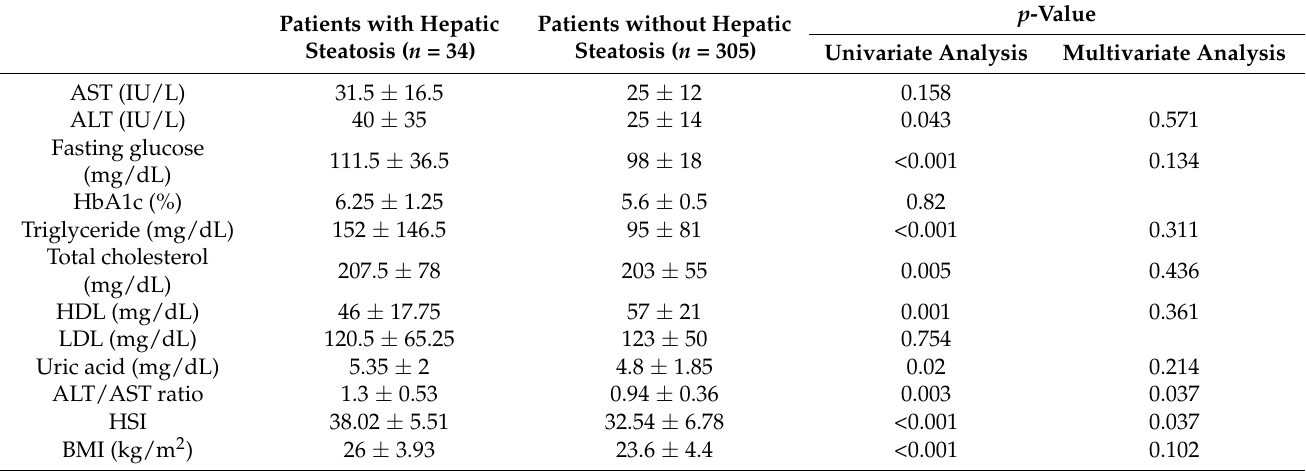
Table 2. Comparison of clinical parameters between the two groups determined by the hepatic steatosis criterion (b; CT L/S < 0.8).